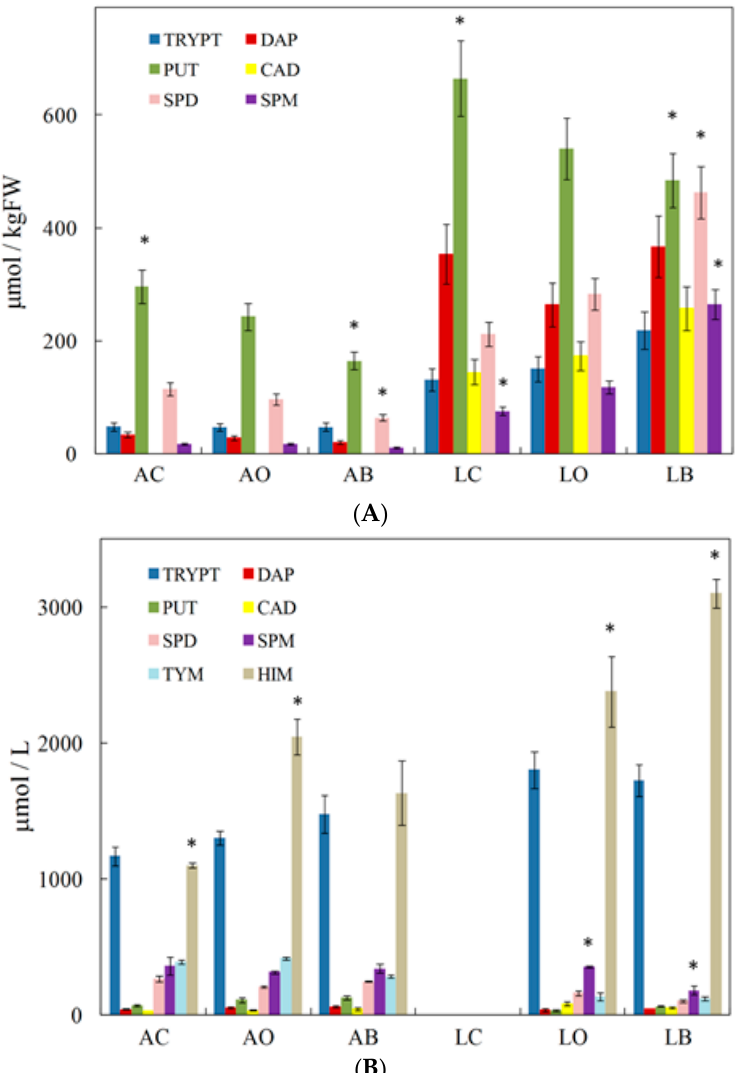
Figure 2. ( A ) Biogenic amine levels ( µ mol/kg) measured in Albana and Lambrusco berries grown following conventional (AC and LC), organic (AO and LO) and biodynamic (AB and LB) agricultural practices. ( B ) Biogenic amine levels ( µ mol/L) measured in Albana and Lambrusco wines obtained following conventional (AC), organic (AO and LO) and biodynamic (AB and LB) oenological practices. The star symbol indicates the statistically significant differences (Student’s t -test, p < 0.05) among single compounds of the same group. Data are the mean ± SE ( n = 4). (from Tassoni et al. [85]).